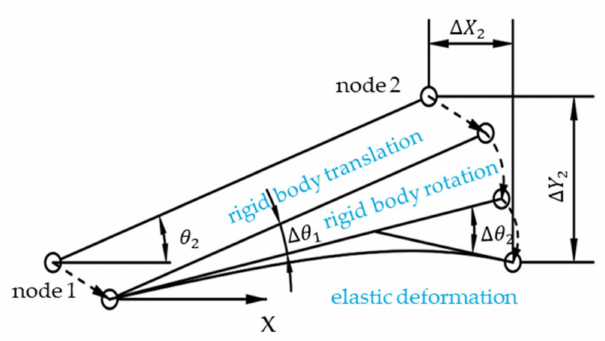
Figure A3. Deformation analysis of Unit